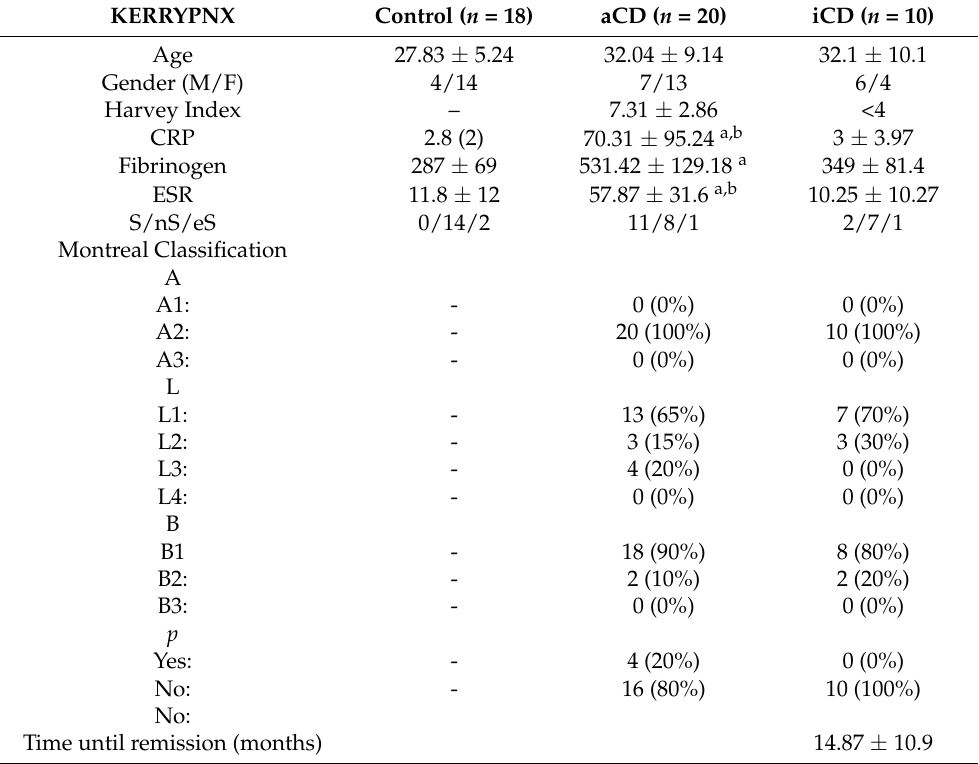
Table 4. Demographic and disease characteristics of the confirmatory human cohort. Controls and CD patients at baseline (active CD) and after achieving disease remission (inactive